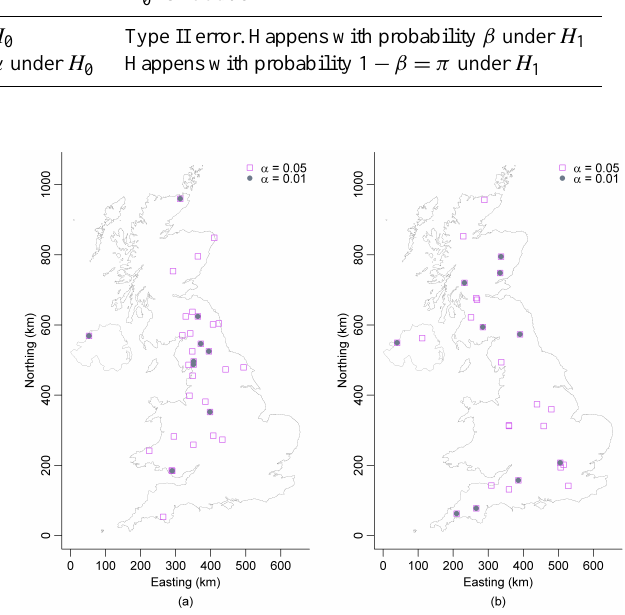
Table 4. Schematic explanation of Type I, Type II errors in relation to the significance level, α , and power, π , of a test. H 0 is true H 0 is not true Test does not reject H 0 Happens with probability 1 − α under H 0 Type II error. Happens with probability β under H 1